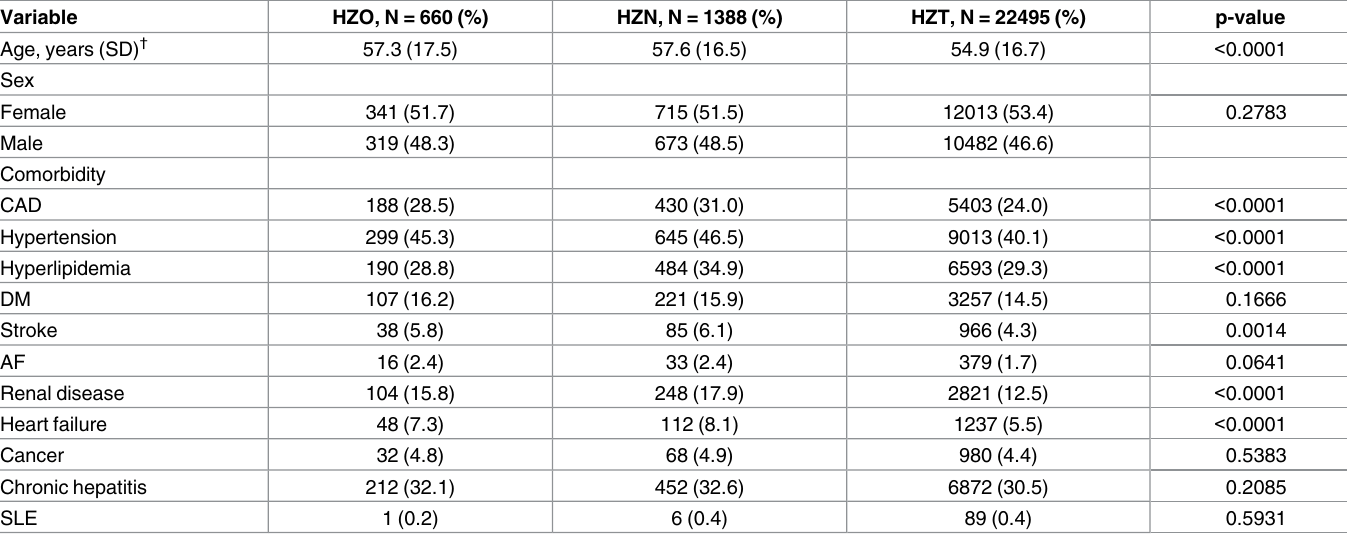
Table 1. Demographic status and comorbidities in the study cohorts.